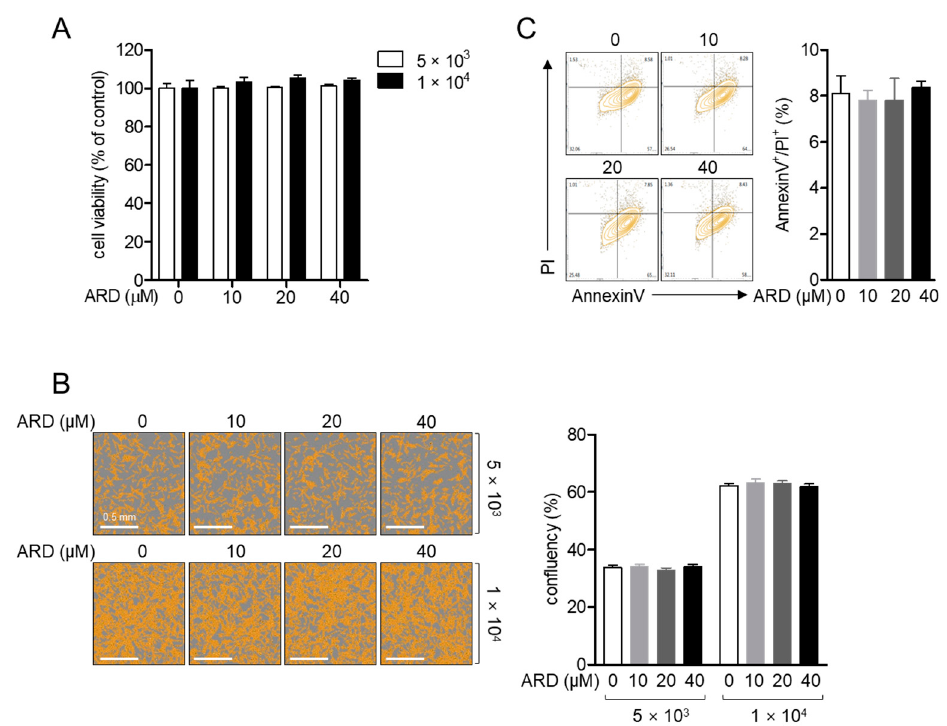
Figure 2. ( A , B ) SH-SY5y cells (5 × 10 3 /well or 1 × 10 4 /well, 96-well plate) were seeded and treated with the indicated concentration (0 to 40 µ M) of aromadendrin for 24 h. Cell viability was measured by methyl thiazol tetrazolium (MTT) assay (A), and confluency was determined by IncuCyte imaging system ( B ). ( C ) Apoptotic cell population was evaluated by AnnexinV/propidium iodide (PI) apoptosis assay in SH-SY5y cells treated with the indicated concentration (0 to 40 µ M) of aromadendrin for 24 h. White bar indicates 0.5 mm. The mean value of three experiments ± SEM is presented.